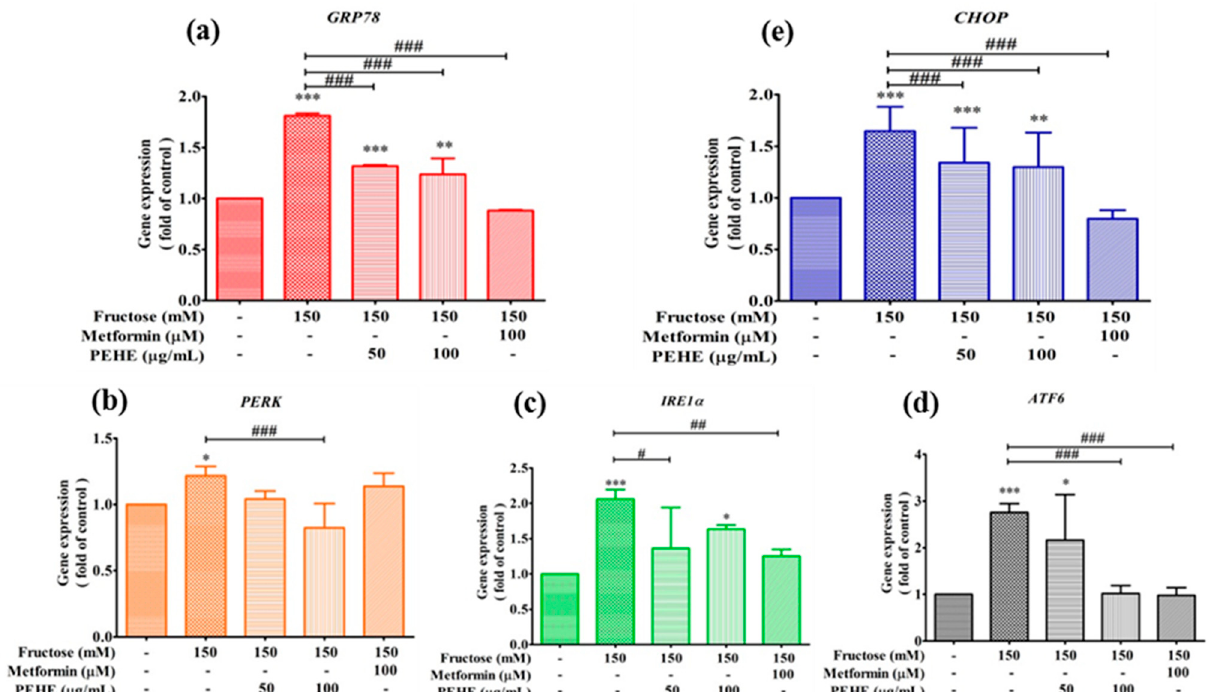
Figure 5. The effects of PEHE and metformin on fructose-induced ER stress relative gene expressions of GRP78 ( a ), PERK ( b ), IRE1 α ( c ), ATF6 ( d ) and CHOP ( e ) in RINm5Fcell. Cells were pre-treated with 150 mM fructose for 2 h and then incubated, with or without PEHE for 24 h. The gene expressions were detected by using the StepOnePlus TM Real Time PCR System. One-way ANOVA was followed by Tukey’s post hoc test. Values are expressed as mean ± standard deviation (n = 3). * p < 0.05, ** p < 0.01 and *** p < 0.001 vs. the control group; # p < 0.05, ## p < 0.01 and ### p < 0.001 vs. the fructose group.